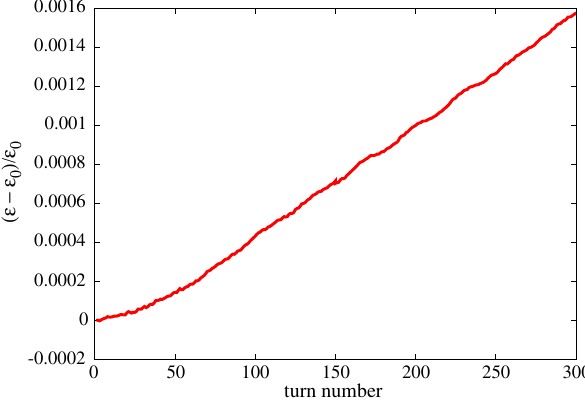
FIG. 21. Estimate of the emittance growth using the full lattice in the model with specified cloud densities in each element of the